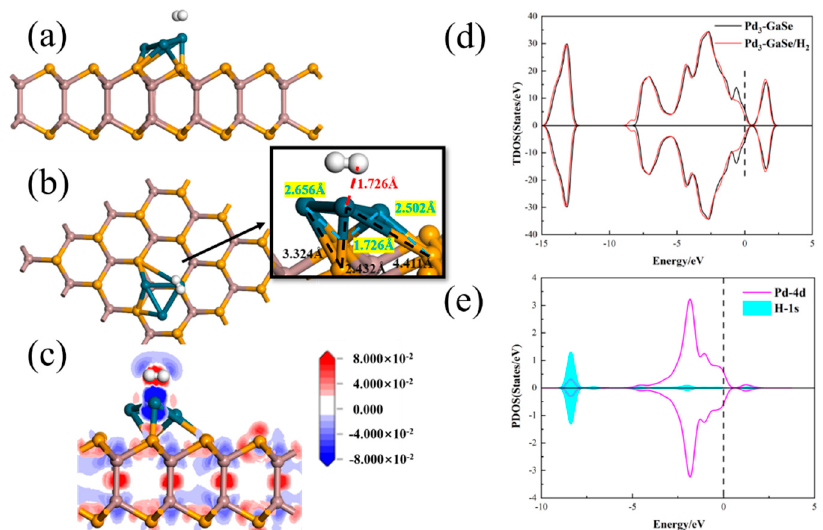
Figure 8. Adsorptive structure of Pd 3 -GaSe/H 2 system ( a ) view of side, ( b ) view of top, ( c ) DCD distribution, ( d ) TDOS of Pd 3 -GaSe/H 2 system, ( e ) PDOS of Pd 3 -GaSe/H 2 system.